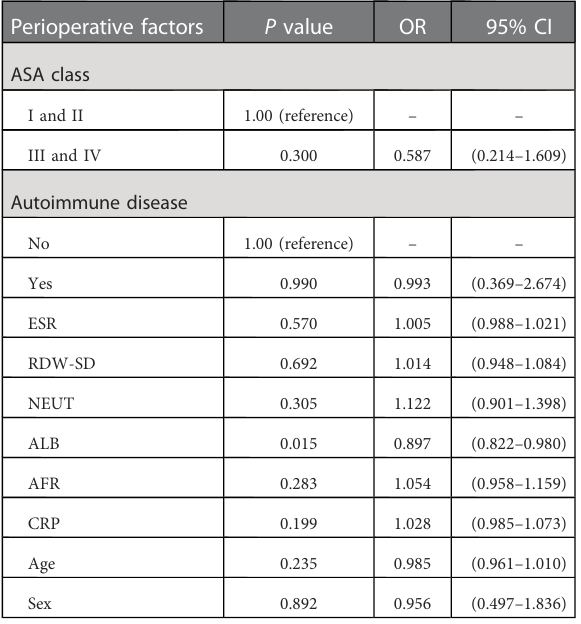
TABLE 2 Multivariable analysis of independent risk factors for acute postoperative infection after TKA or THA. Perioperative factors